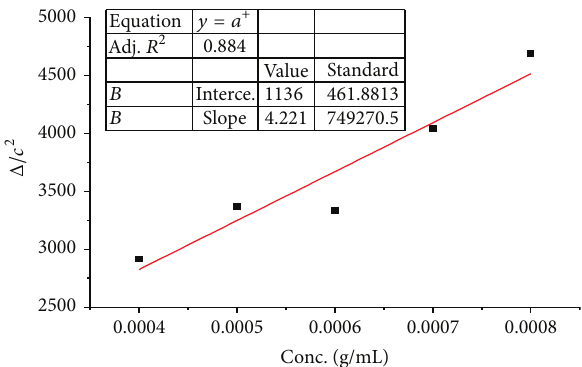
Figure 1: Dependence of Δ / c 2 on the concentration of sample 6 ( 𝑅 2